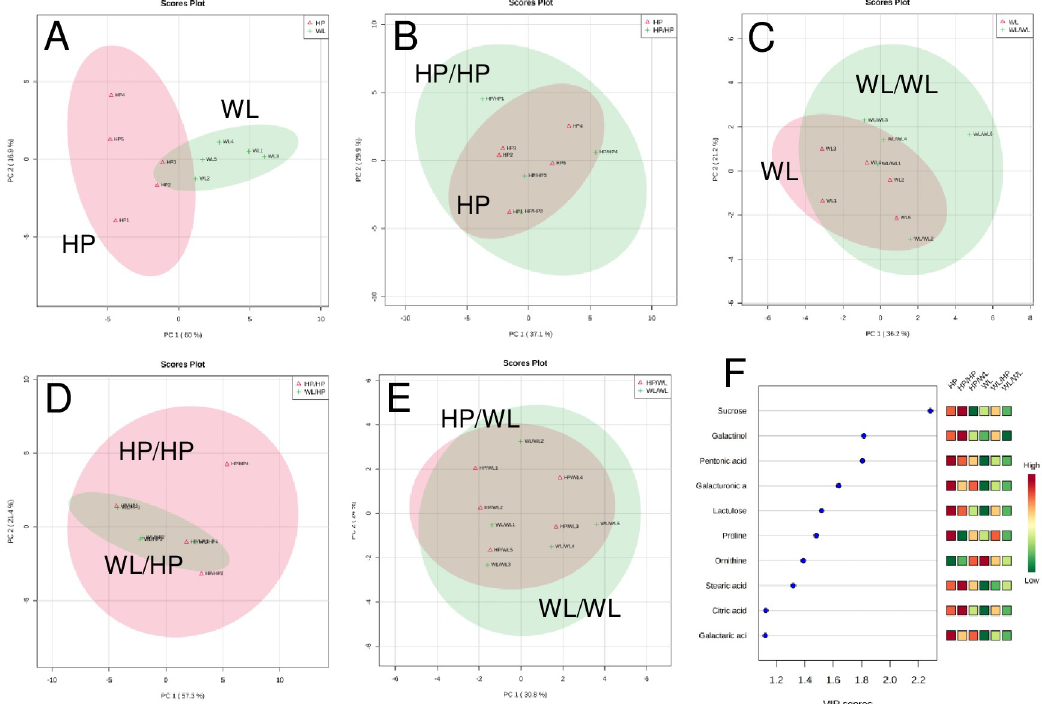
Fig 4. PCA and VIP plots from PLS-DA showing the metabolite differences in freshly harvested mature tubers of non-grafted (A), homo-grafted (B and C) and hetero-grafted (D and E) plants. The VIP plots (F) indicate the major differences between each category. In each plot, the 95% confidence regions are displayed. The tuber data were obtained from the same two consecutive experiments as those presented in Fig 3 for leaves. Each sample was prepared from 3 tubers approximately 1.5–2.0 cm in diameter. The data were obtained from 4–5 samples of each plant category. The labels are as in Fig